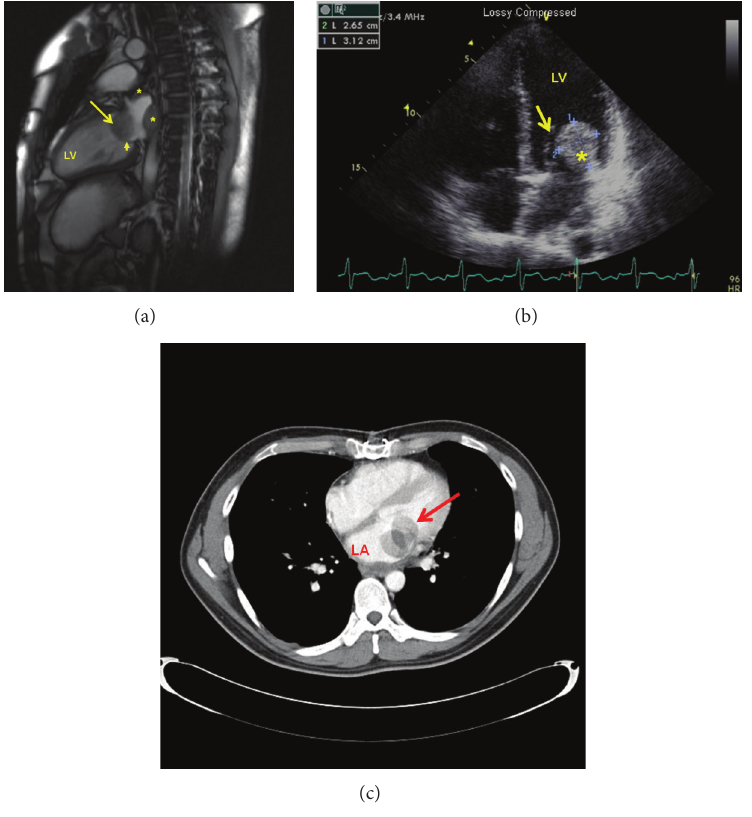
Figure 1: Presentation 2. (a) MRI showing mass in the left side of the heart pressing on the mitral valve (arrow head) and two other masses in the left atrium indicated (asterisks). (b) TEE showing a mobile, echogenic mass (asterisk) in the left heart prolapsing through the mitral valve (arrow) into the ventricle. (c) Nongated CT-scan captured the mass (arrow) in motion in the left side of the heart. LA: left atrium. LV: left ventricle.